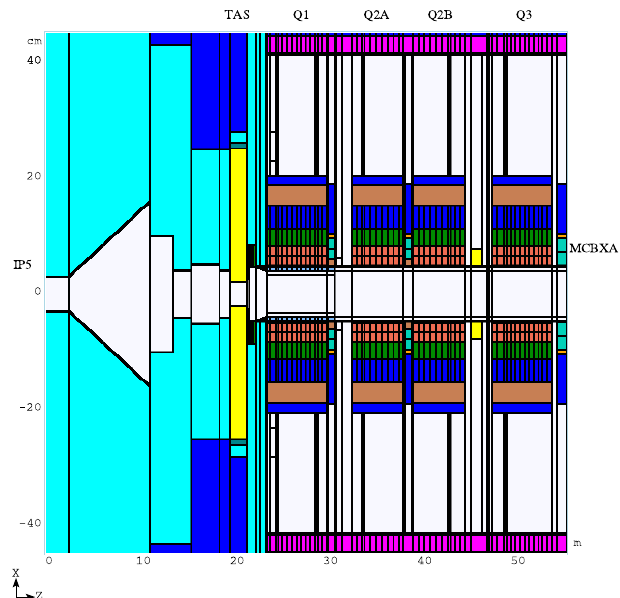
FIG. 1. (Color) Schematic view of the IP5 model with